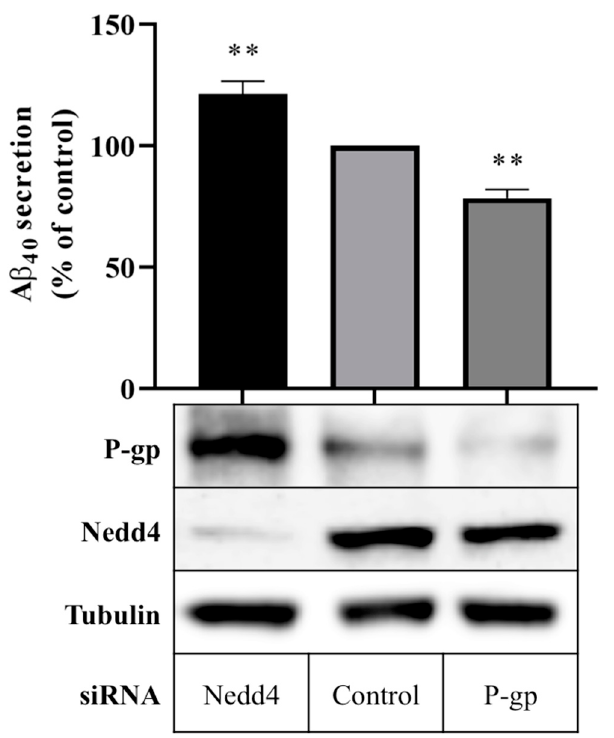
Figure 2. Effect of Nedd4 knockdown on A β export from CHO-APP cells. CHO-APP cells were transfected with Nedd4 or P-gp siRNA or universal control. Following the initial 24 h transfection period, transfection media was changed to fresh full culture media. After a further 24 h incubation period, cell media were collected for quantification of A β 40 content by ELISA, and cells were harvested for Western blot analysis. The column graph shows the relative secretion of A β 40 peptides into media over 24 h compared with control. Immunoblots confirm the knockdown of Nedd4 and enhancement of P-gp protein expression in Nedd4-siRNA treated cells compared with control. Tubulin was used as a loading control. Data reflect the mean ± SEM of three independent experiments. ** p ≤ 0.01 compared with control.